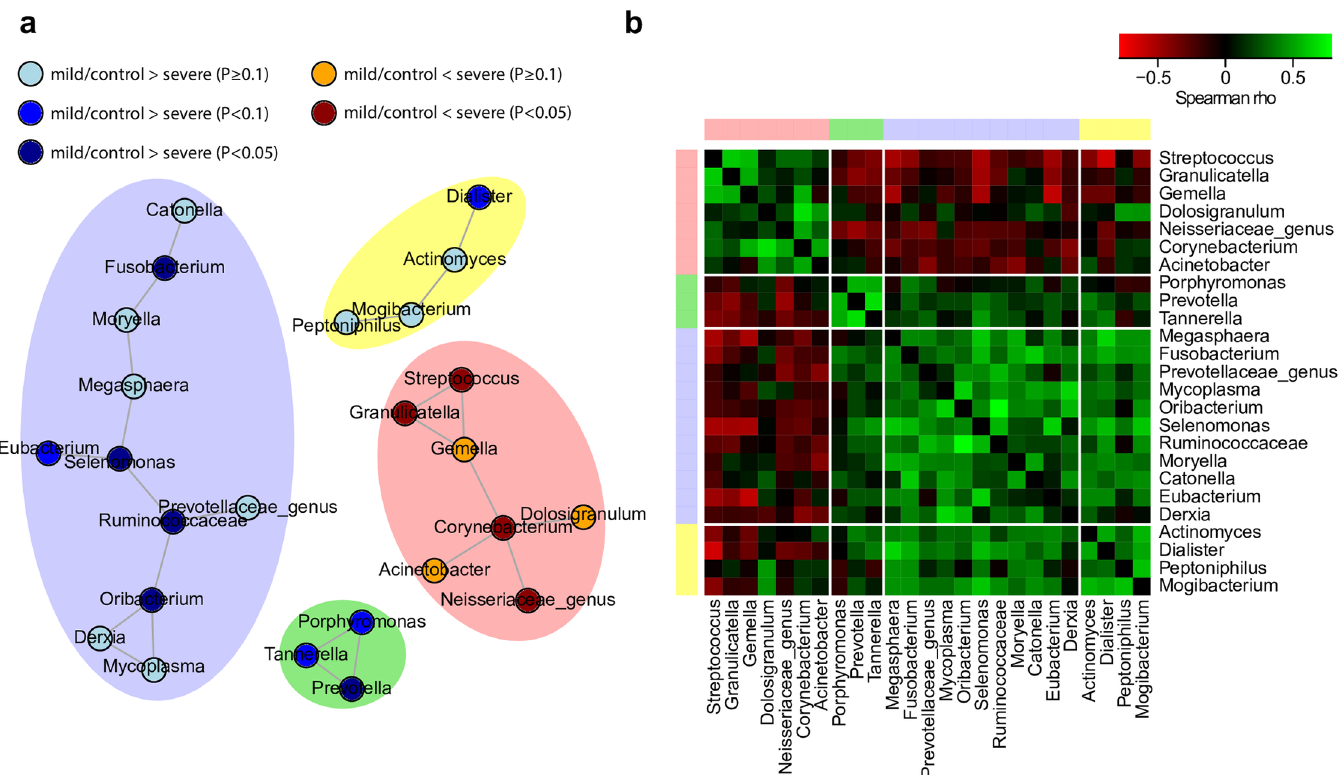
Fig 4. Co-occurrence analysis of bacterial genera. ( a ) Microbialcorrelationnetwork of bacterialgeneraas a surrogate for bacterialinteraction. Each node represents one microbialgenus and shadingcolors (blue, red, green, yellow) highlightmicrobialcommunities. Coloringof nodes indicatesdifferences betweensevere subtype versus mild subtype cases and controls (red colors: higheraverageabundance in severe subtype cases; blue colors: higher averageabundance in mild subtype cases and controls). Communities containing (cid:20) 2 generawere not shown. ( b ) Heatmap showingspearmancorrelation coefficients betweenbacterialgenerafrom the four microbialcommunities.Colors at the upper and left side of the figure indicate the community affiliation of respective genera.